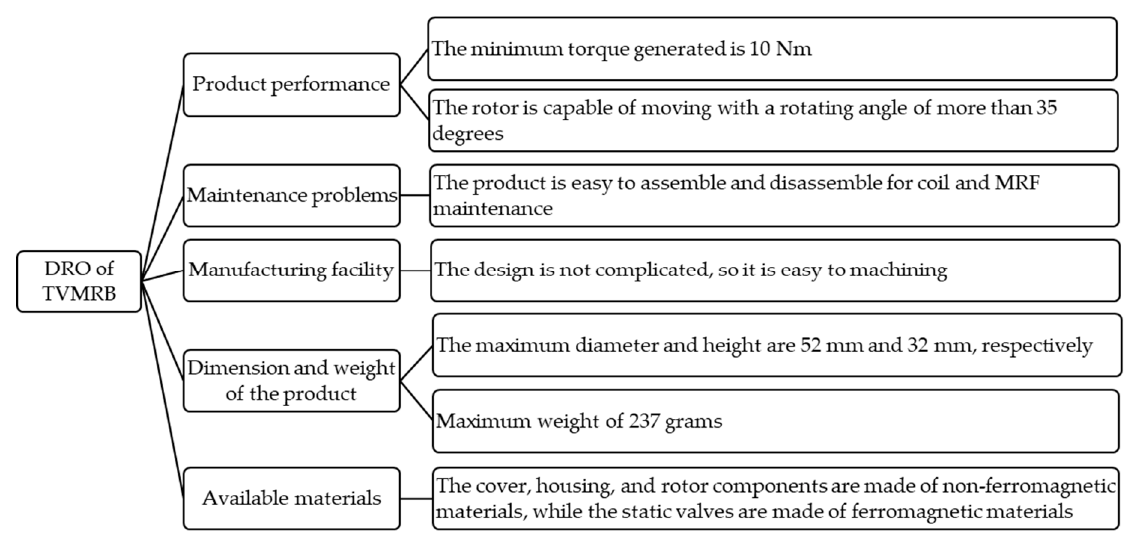
Figure 2. Design requirements of TVMRB and objective of the research.